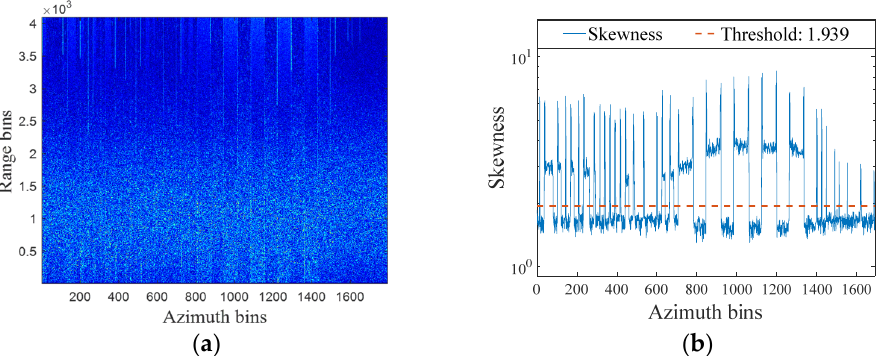
Figure 16. The NBI detection results on the measured SAR data corrupted with NBI: ( a ) the NBI contaminated SAR data in the two-dimensional time domain; ( b ) the NBI detection results of ( a ) via the TF skewness detection algorithm.